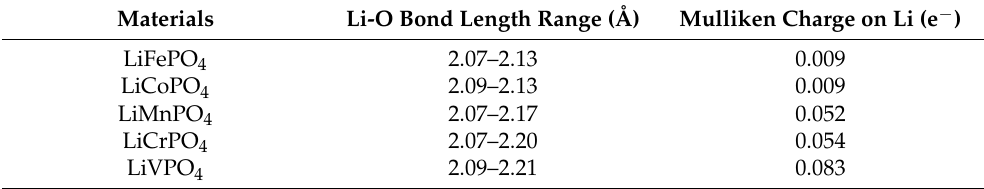
Table 2. The Li-O bond length and Mulliken Charge on Li in Olivine LiMPO 4 .